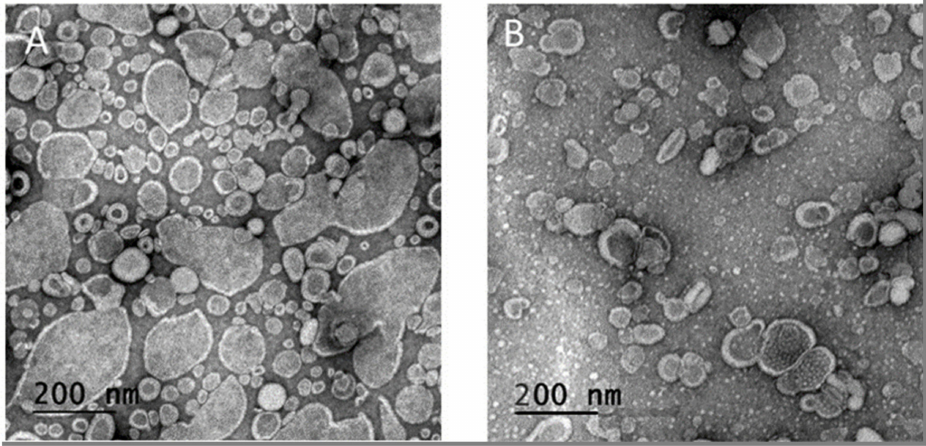
Figure 2. TEM images of neutral formulations. ( A ) NL and ( B ) NvcL